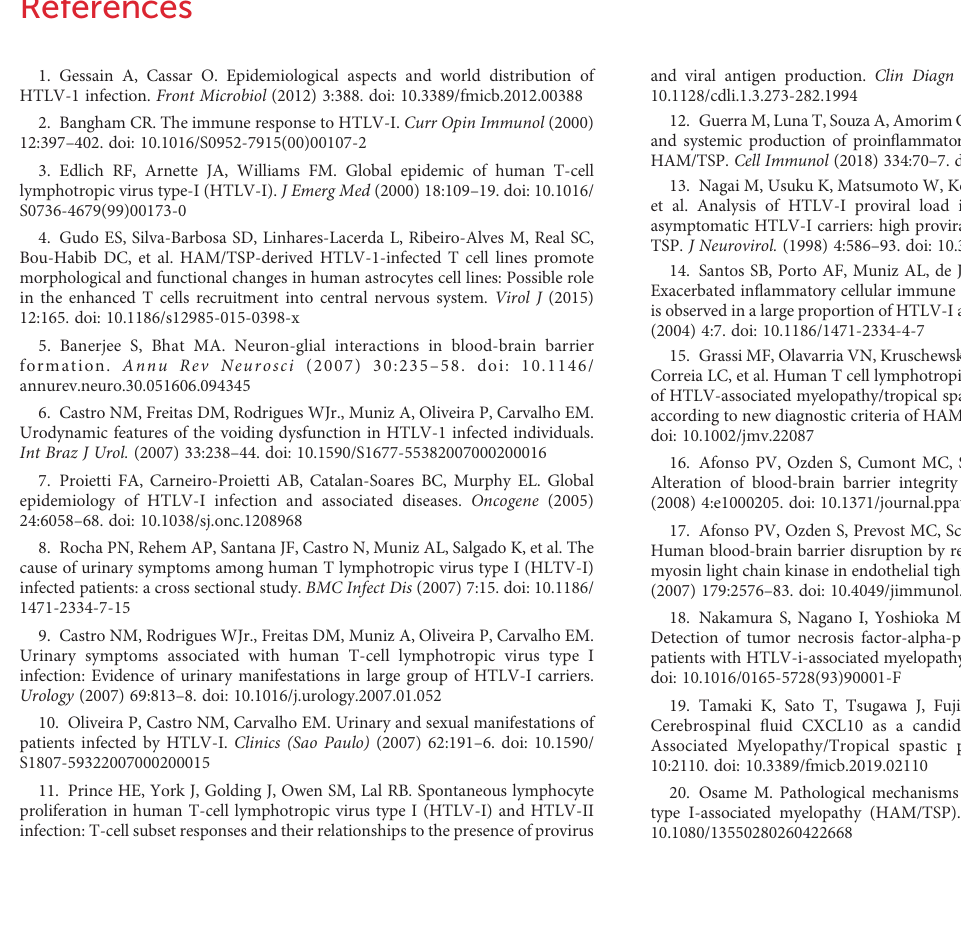
SUPPLEMENTARY FIGURE 1 Increased proviral load and high TNF production in HAM/TSP patients. (A) Proviral load values from HTLV-1 carriers, OAB-HTLV-1-infected and HAM/TSP patients, as assayed by PCR. (B) PBMCs from HTLV-1 carriers, OAB-HTLV-1-infected and HAM/TSP patients were cultured for 72h, after which TNF levels were assessed by ELISA. Bars represent median values from each group. Nonparametric testing (Mann-Whitney) was used to compare among